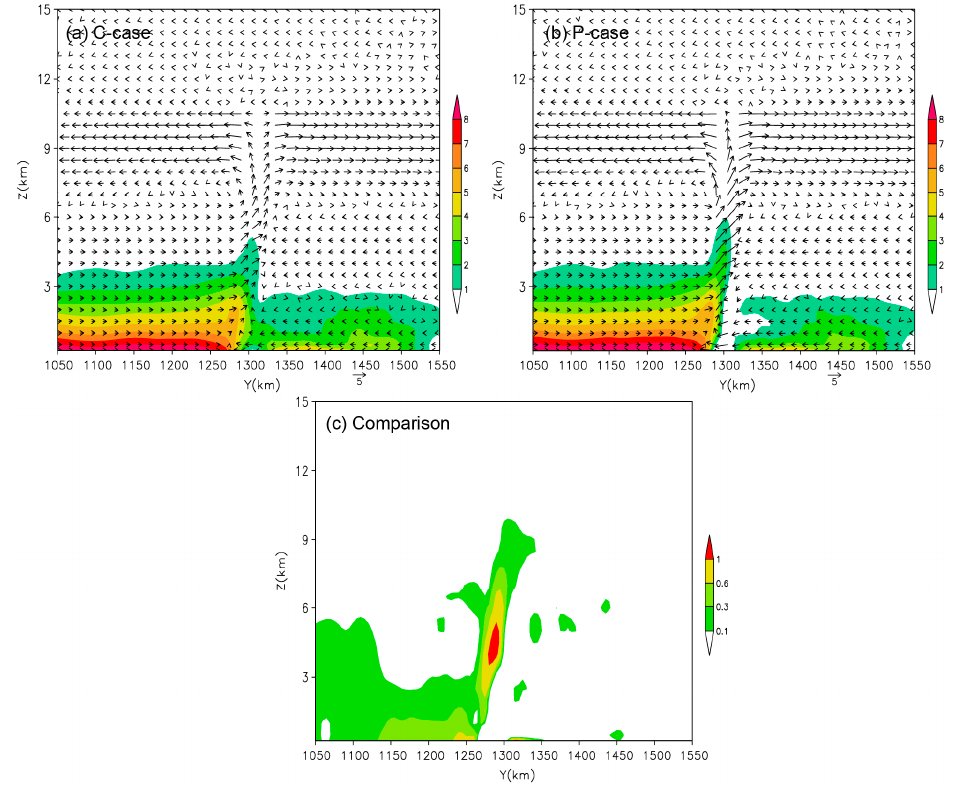
⋅ , shading, ⋅ ′ , shading, at t = 21 h for ( a ) C-case ′ at t = 21 h for ( a ) C-case